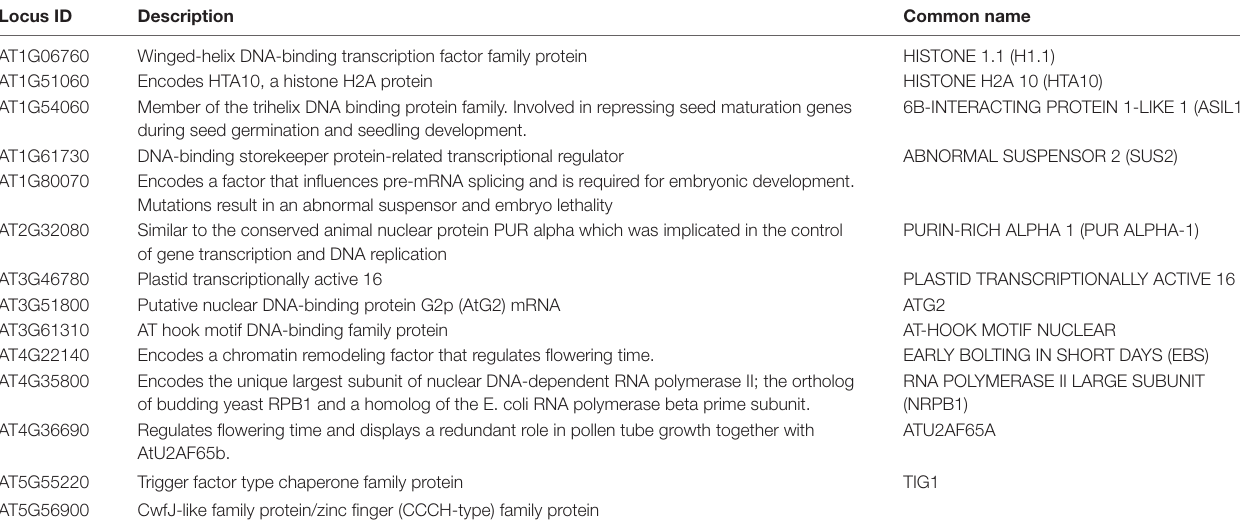
TABLE 3 | COBRA1-interacting proteins involved in transcriptional regulation. Locus ID